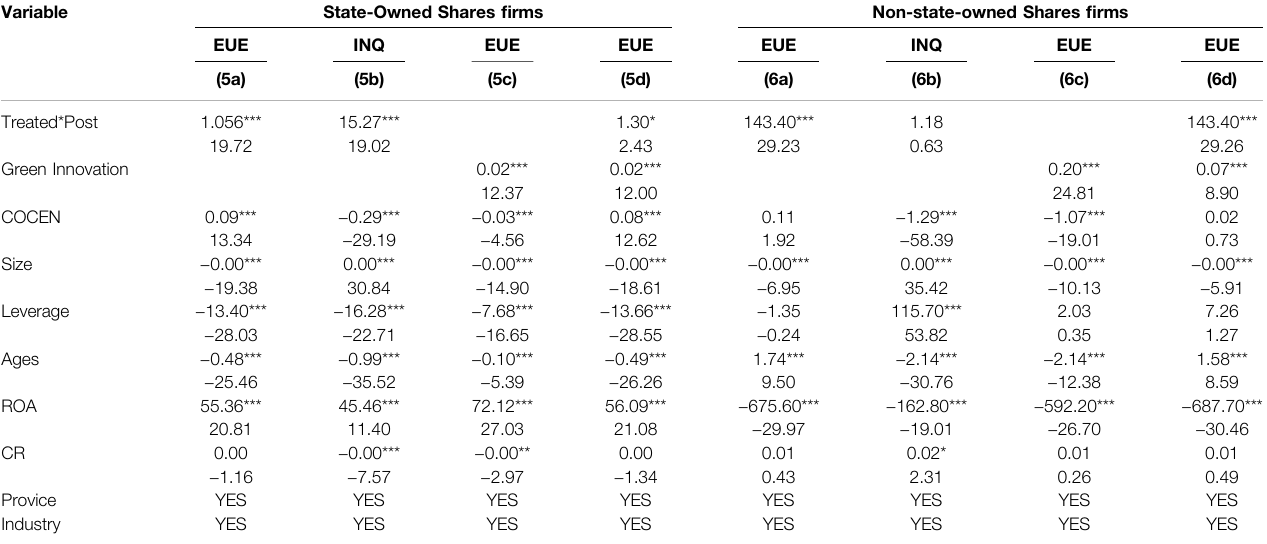
TABLE 10 | Heterogeneity test about regulation.